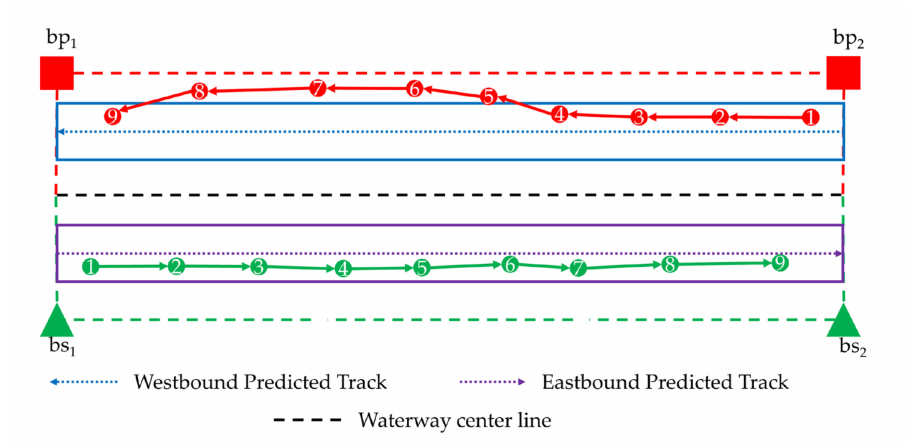
Figure 14. Relative amount of tracks that are contained within the previously calculated directional corridors for each cell in the waterway.